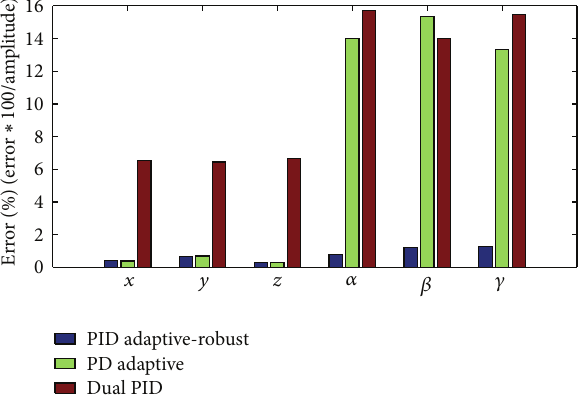
Figure 12: Pose error percentage in three types of the control